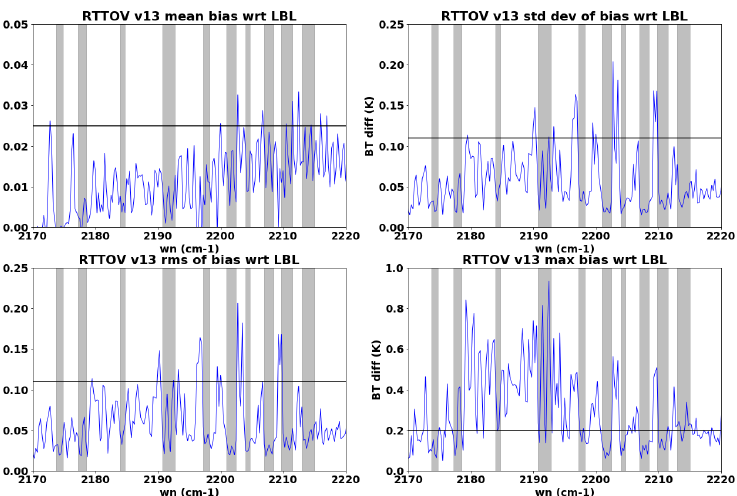
Figure 2. RTTOV version 13 (with coefficients version 13) bias analysis with respect to line by line calculations with LBLRTM v12.8, for the set of 83 profiles used to train RTTOV, in Brightness Temperature (BT) units: mean bias (with horizontal black line at 0.025 K), standard deviation of the bias (with horizontal black line at 0.11 K), root-mean-square (rms, with horizontal black line at 0.11 K) of the bias and maximum bias (with horizontal black line at 0.2 K), as a function of the wave number (wn). The gray areas show our N 2 O retrieval spectral